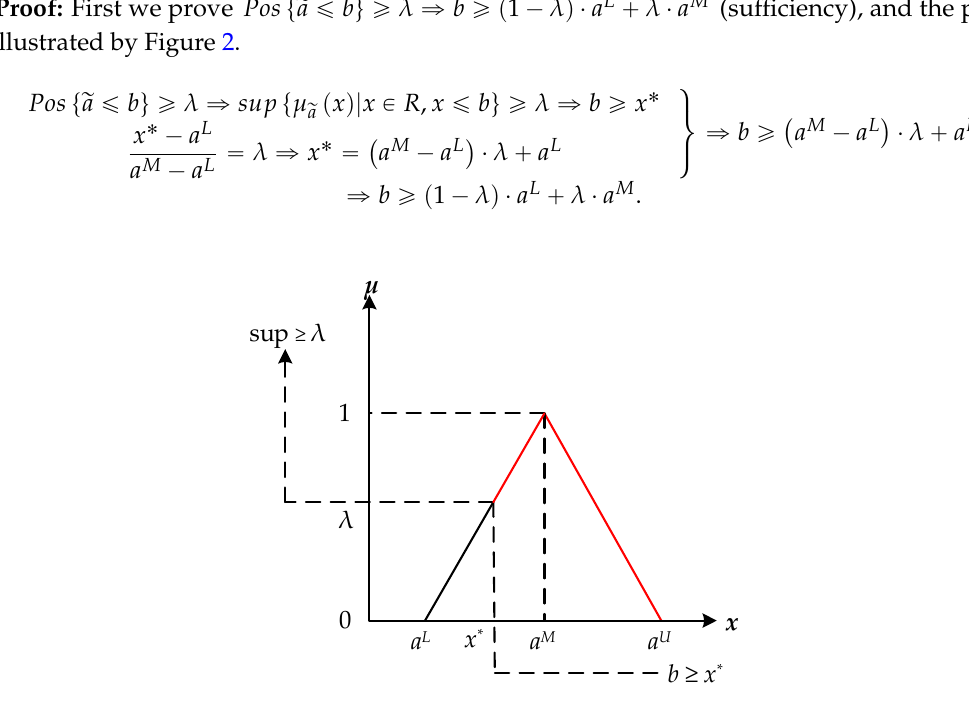
Figure 2. Diagram of the sufficiency proof.